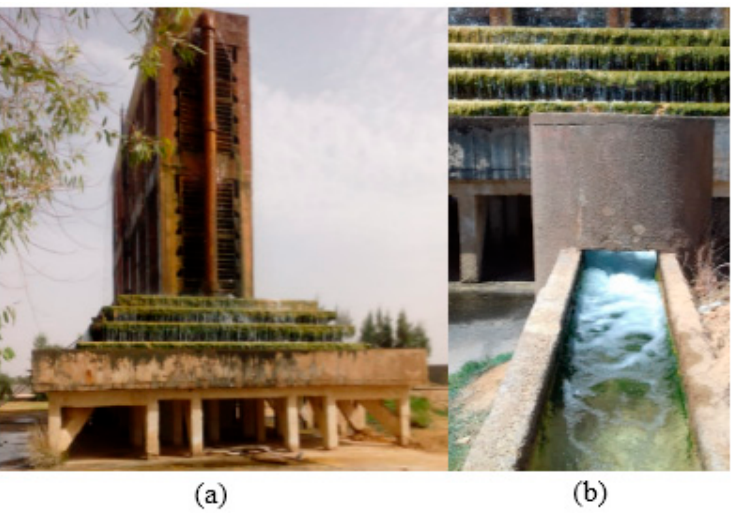
Figure 2. ( a ) Cooling system ( b ) irrigation canal.